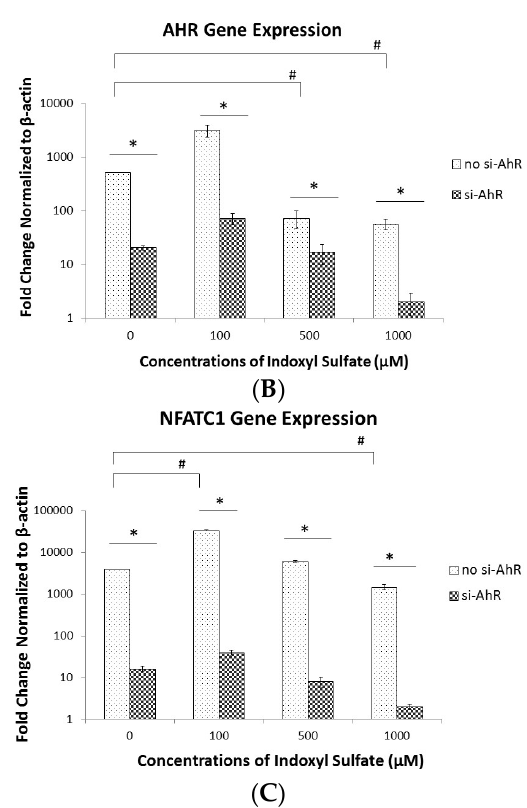
Figure 4. E ff ect of AhR antagonism on NFATc1 expression. ( A ) Raw 264.7 cells with 50 ng / mL of sRANKL were cultured in IS at 0, 100, 500, and 1000 µ M for 3 or 5 days. NFATc1 expression was inhibited by CH223191 on Day 3. Western blot analysis showed that NFATc1 expression was significantly inhibited by CH223191 at < 100 µ M IS. Error bars represent mean ± SD ( n = 3). * p < 0.05 compared to with or without CH223191 at individual IS concentrations. ( B ) E ff ect of AHR knockdown on AHR gene expression. Raw 264.7 cells with or without transfected AHR siRNA (si-AHR) were cultured for 24h and then treated with di ff erent IS concentrations for another 48 h. The fold changes in gene expression levels were determined by real-time quantitative polymerase chain reaction (qRT-PCR) and calculated relative to the control group, normalized to actin. The expression of the AHR gene without transfected si-AHR was significantly lower in the 500 and 1000 µ M IS treatment groups than in the 0 µ M group. Its expression in the si-AHR groups was significantly lower than in the non-si-AHR groups. Error bars represent mean ± SD ( n = 3). * p < 0.05 compared with and without transfected si-AHR. # p < 0.05 compared with 0 µ M IS in non-si-RNA groups. ( C ) E ff ect of AHR knockdown on NFATC1 gene expression levels. Raw 264.7 cells with or without transfected AHR siRNA (si-AHR) were cultured for 24h and treated with di ff erent IS concentrations for another 48 h. The fold changes in gene expression levels were determined by qRT-PCR and calculated relative to the control group, normalized to actin. NFATC1 expression without transfected si-AHR was significantly lower in the 1000 µ M IS treatment group than in the 0 µ M group. NFATC1 expression without transfected si-AHR was significantly higher in the 100 µ M IS treatment group than in the 0 µ M group. NFATC1 expression was significantly lower in the si-AHR groups than in the non-si-AHR groups. Error bars represent mean ± SD ( n = 3). * p < 0.05 compared with and without transfected si-AHR. # p < 0.05 compared with 0 µ M IS in non-si-RNA